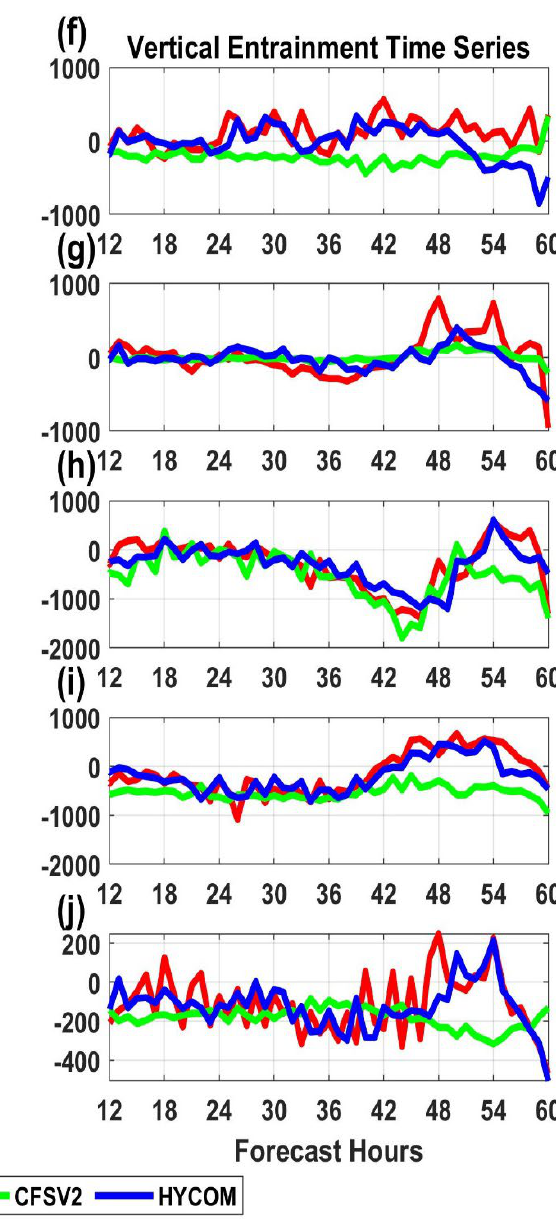
Figure 9. Quadrant-wise variations in the ML heat storage term ( a – e ) and the vertical entrainment term ( f – j ) (calculated over the VFB) obtained from the three experiments. term ( f – j ) (calculated over the VFB) obtained from the three